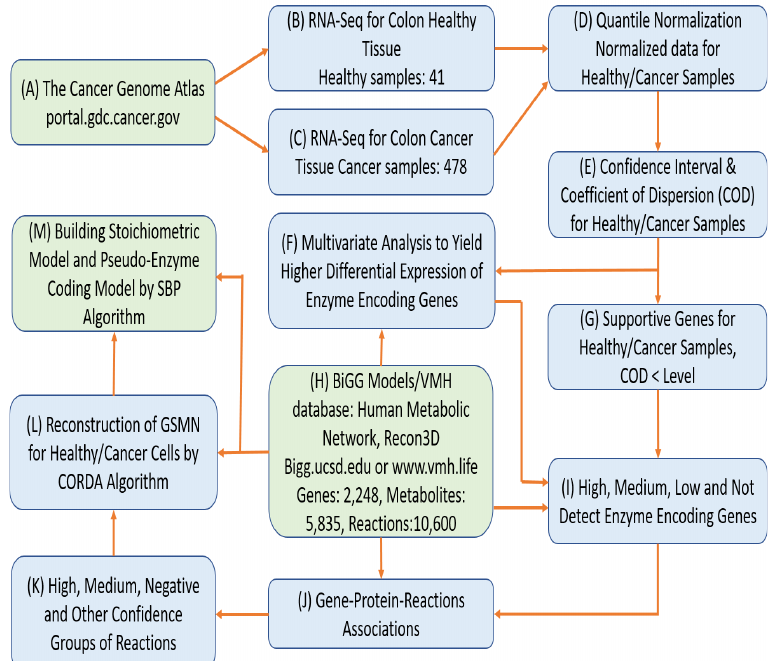
Figure 1. Roadmap of the reconstruction of genome-scale metabolic models. Workflows for recon- structing genome-scale metabolic models for CRC and its corresponding healthy tissue. (A) Down- load RNA-Seq data of CRC from the TCGA database. (B–G) A series statistical analyses of the download RNA-Seq data. (H) Download general human metabolic network model (Recon3D) from Bigg Models or VMH database. (I) Integrate the Recon3D model with the RNA-Seq data to classify all enzyme-encoded genes into four classes. (J) Retrieve gene-protein-reaction associations from the Recon3D model. (K) Compute the confidence score for each reaction based on the gene-protein- reaction associations, and classify all reactions into four groups. (L) Reconstruct tissue-specific metabolic models for healthy and cancer cells using the CORDA algorithm. (M) Create GAMS codes for tissue-specific metabolic models using the SBP